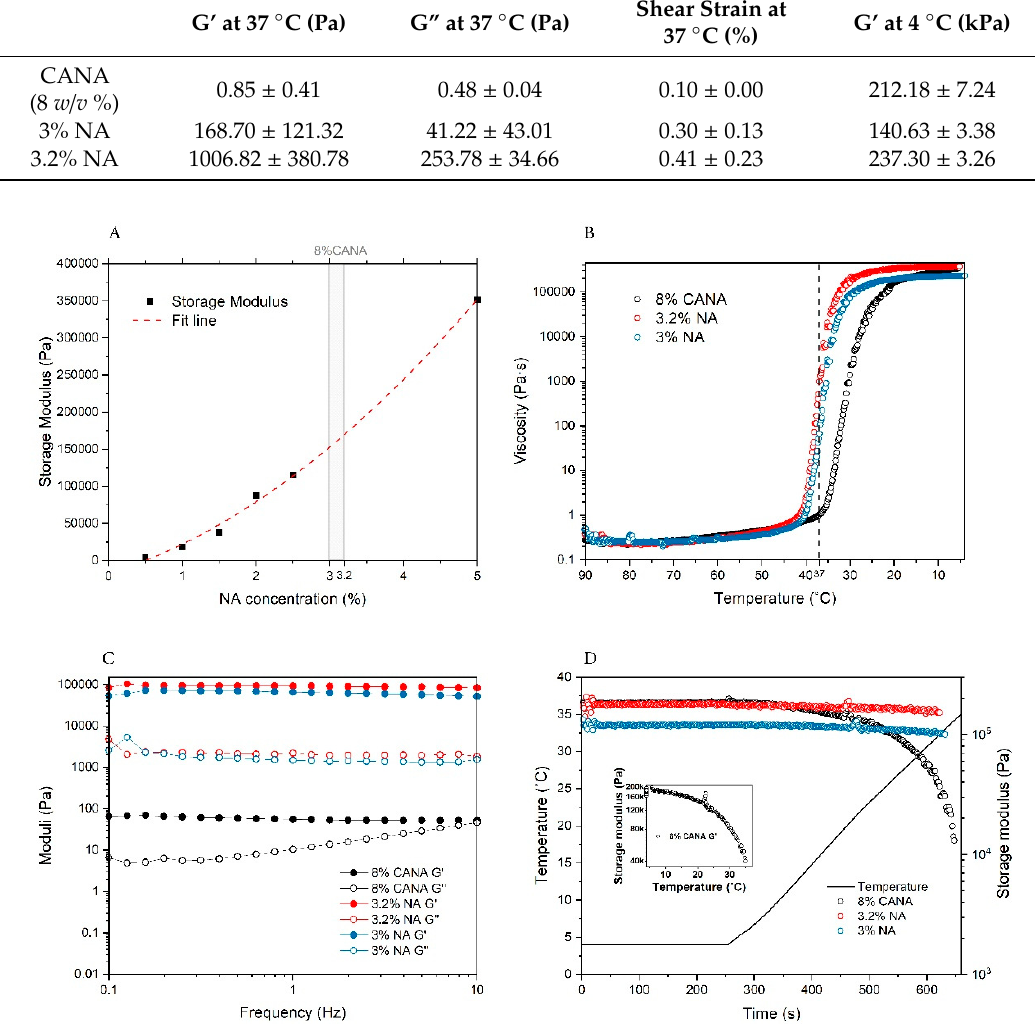
Figure 1. Rheological properties of the CANA bioink compared to NA. ( A ) Estimation of the concentration of NA necessary to achieve the sti ff ness of the CANA bioink formulation at 4 ◦ C determined using a NA standard curve. The storage modulus of the CANA bioink is depicted by the grey rectangle area. ( B ) Comparison of the viscosity of CANA bioink, 3% NA, and 3.2% NA under a temperature sweep. Dash line represents 37 ◦ C. ( C ) Comparison of the storage modulus and loss modulus of CANA bioink, 3% NA, and 3.2% NA under a frequency sweep from 0.1 Hz to 10 Hz under 37 ◦ C. ( D ) Thermal recovering properties of the CANA bioink, 3% NA, and 3.2% NA. The inset shows the storage modulus of CANA bioink as function of temperature. (n = 3). Table 1. Comparison of the moduli and shear strain of different formulations in the sol state at 37 °C and in the gel state at 4 °C (n = 3).